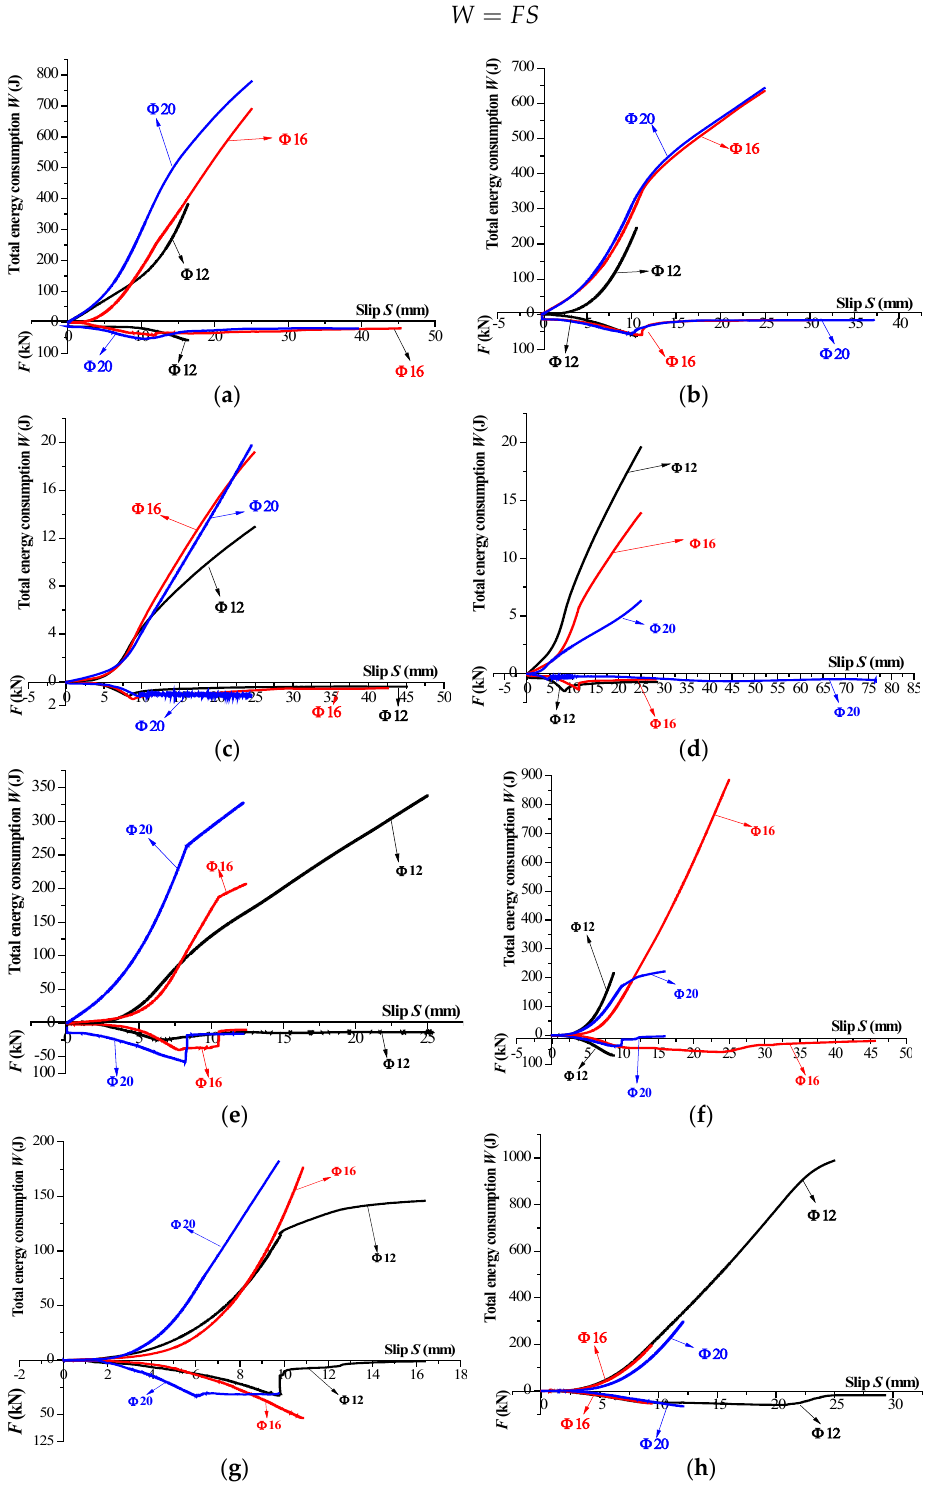
Figure 6. The relationships between F–S curves and W–S curves for different specimens. ( a ) LWCSB-1-CRB-50; ( b ) LWCSB-1-CRB-100; ( c ) LWCSB-2-PSB-50; ( d ) LWCSB-2-PSB-100; ( e ) LWCSB-2-CRB-100; ( f ) LWCSB-3-CRB-50; ( g ) LWCSB-3-CRB-100; ( h ) Table 5. The total energy consumption with representative specimens.